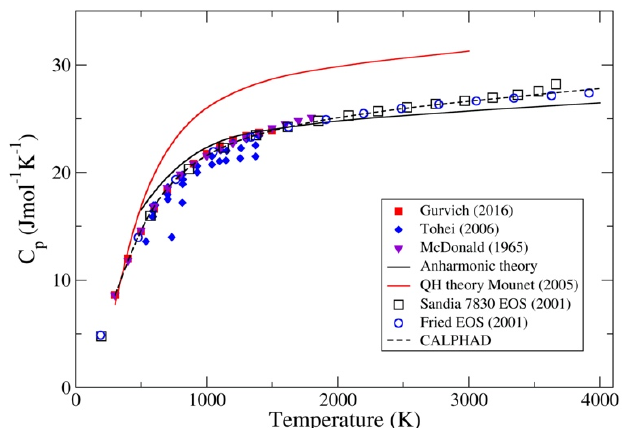
Figure 4. Experimental (red squares) [38], (blue diamonds) [8], and (purple triangles) [39] specific heats. Anharmonic (black line), quasi-harmonic (QH) (red line) [7], Sandia EOS model (open black squares) [33], Fried et al. EOS model (open blue circles) [40], and CALPHAD (black dashed line) [32] specific heats.